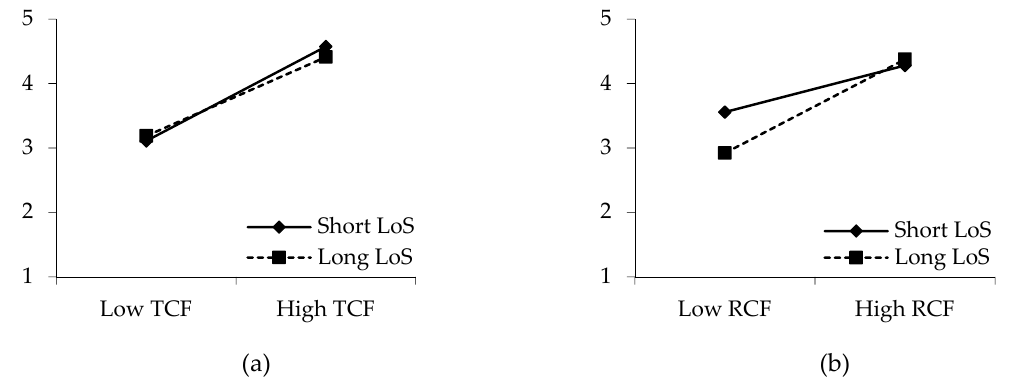
Figure 4. Moderating effects of the length of joining in the company (LoS) between (a) transactional contract fulfillment (TCF) and task performance (TP) and (b) relational contract fulfillment (RCF) and task performance (TP).